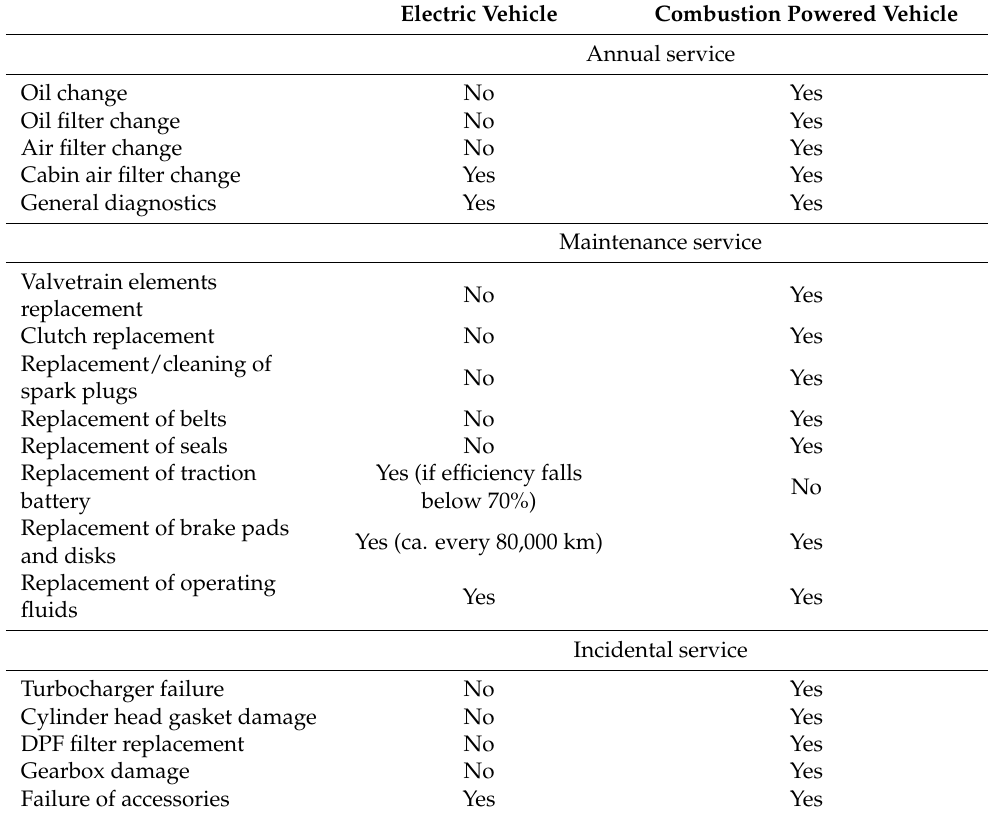
Table 1. Maintenance service of an electric and combustion-powered